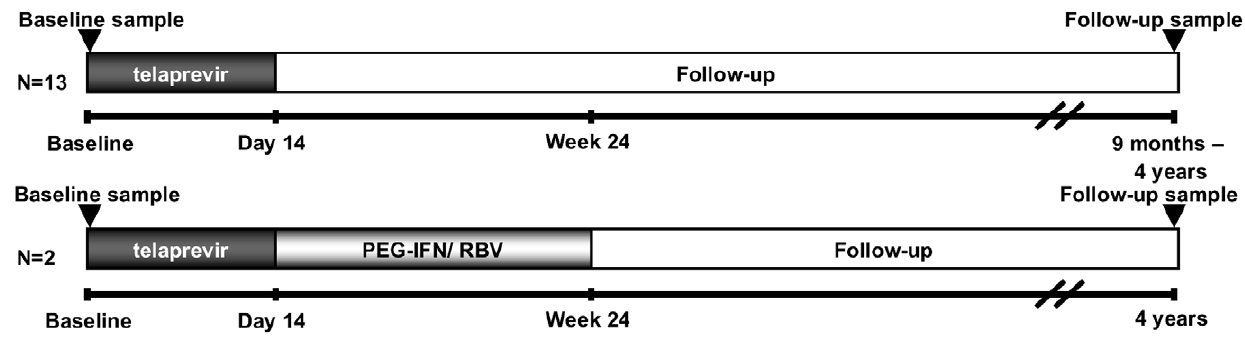
Figure 1. 101 and 103 Study design. All 15 patients received TVR monotherapy for 14 days. Off-study treatment with PEG-IFN and RBV was offered to all study participants after day 14. Only 2 patients received the off-study standard of